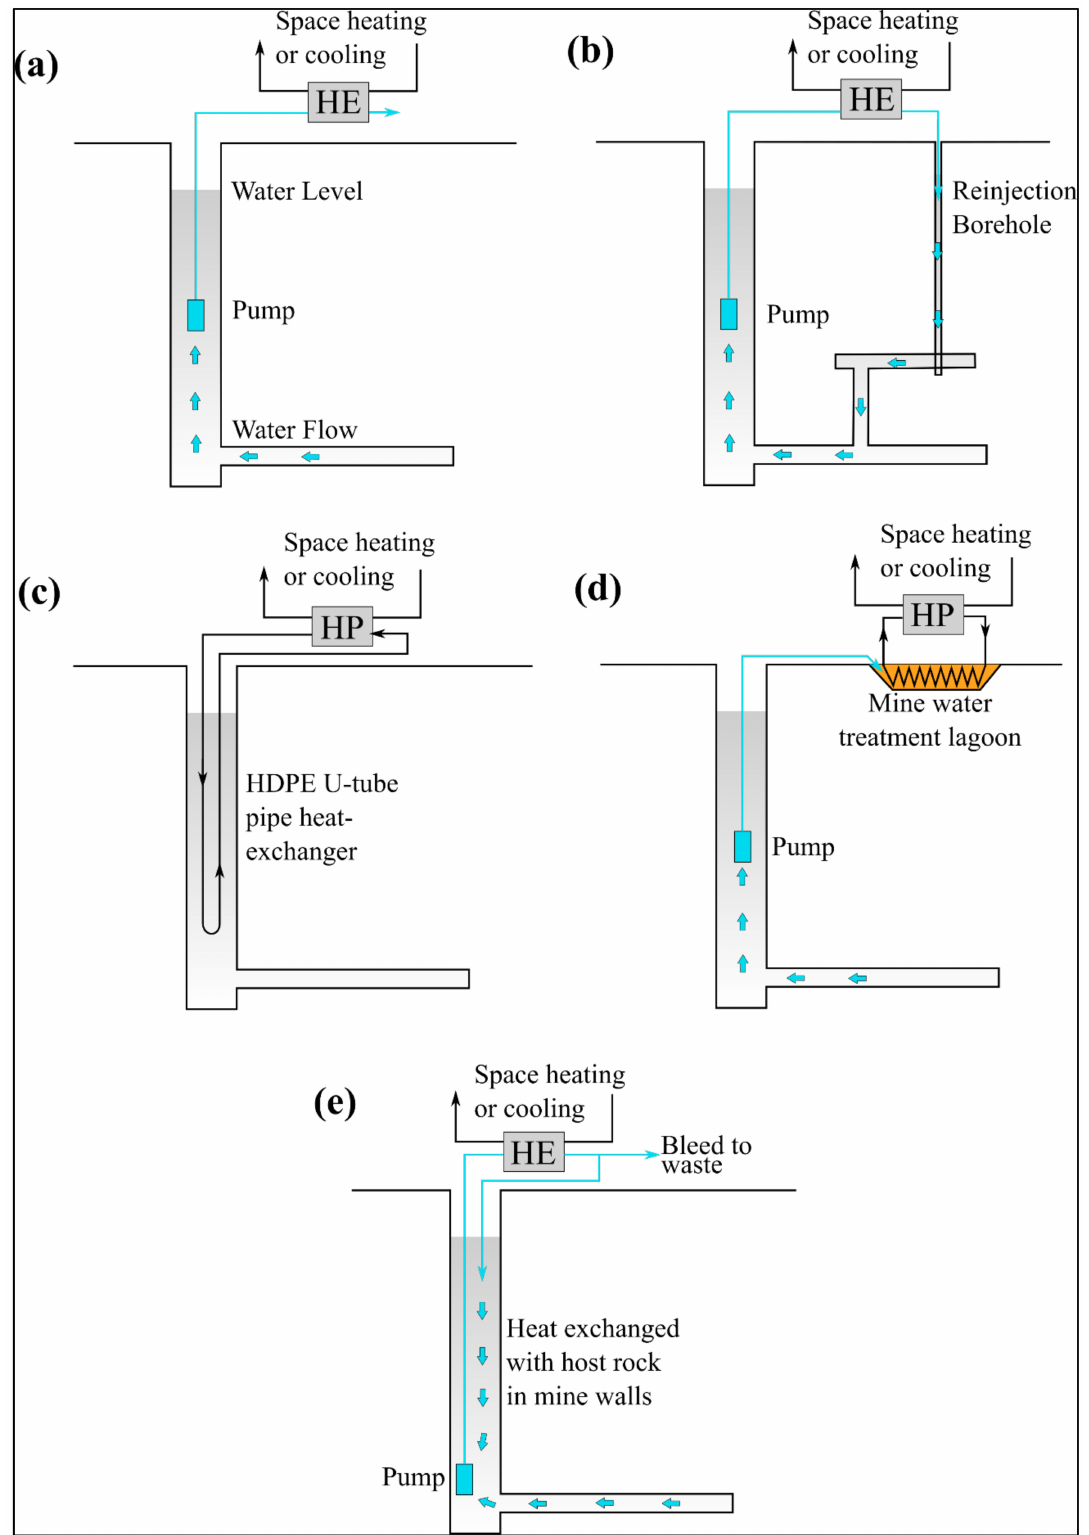
Figure 3. Configurations of Minewater Geothermal Energy Systems: ( a ) Open system with discharge; ( b ) Open system with reinjection; ( c ) Borehole Closed loop; ( d ) Surface closed loop; ( e ) Standing column. Reprinted (with modifications) with permission from ref. [40]. Copyright 2016 David